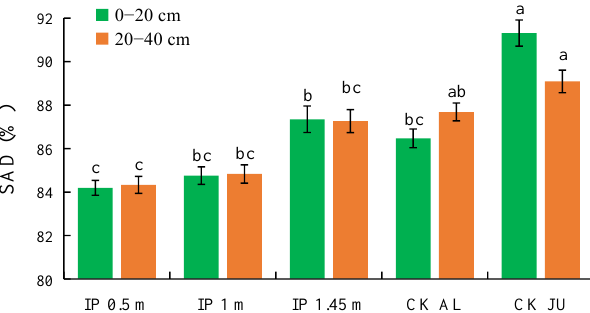
Figure 8. Distribution of soil aggregate destruction rate (SAD).